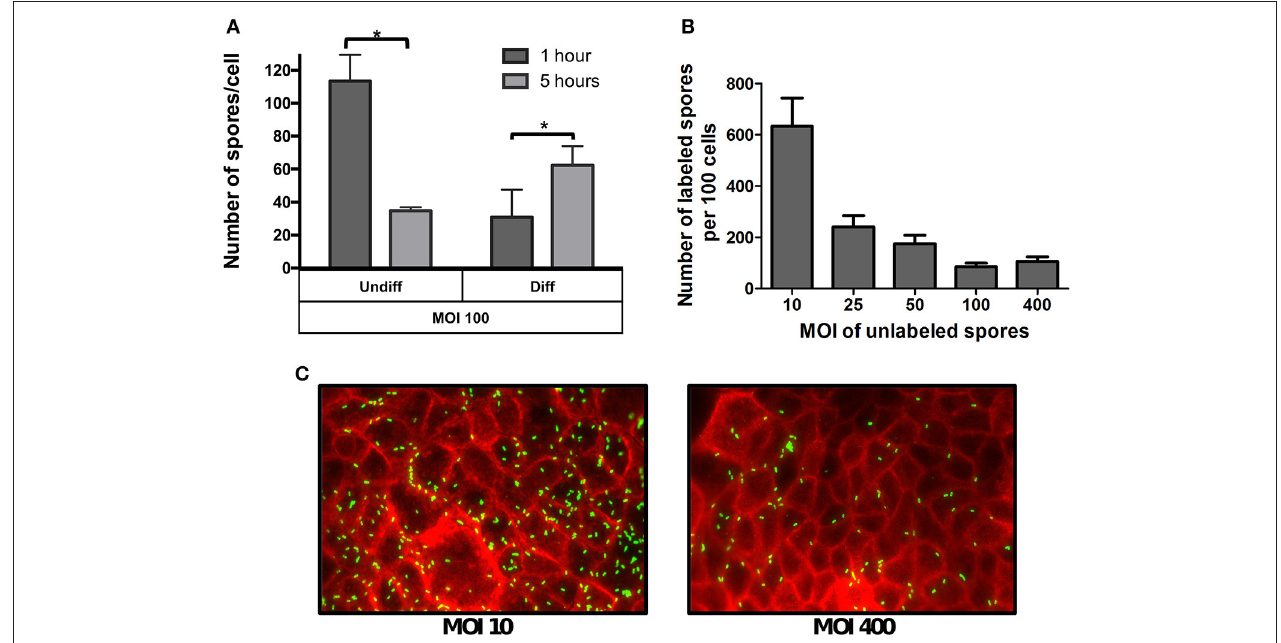
FIGURE 2 | Effect of the multiplicity of infection on spore adherence to intestinal epithelial cells. (A) Monolayers of undifferentiated (Undiff) and differentiated (Diff) Caco-2 cells were infected at multiplicity of infection (MOI) of 100 for 1 (dark gray bars) or 5h (light gray bars), respectively. Unbound spores were rinsed off and, total cells and adhered spores were determined as described in the Method section. (B) Competitive binding of unlabeled and fluorescently labeled C. difficile spores. Monolayers of differentiated Caco-2 cells were infected with different MOIs of unlabeled C. difficile 630 spores for 3h. Then unbound spores were rinsed off, and subsequently infected for 3h at an MOI of 10 with fluorescently labeled C. difficile spores. Unbound fluorescently labeled spores were rinsed off and subsequently processed and the number of fluorescently labeled analyzed by fluorescent microscopy. (C) Representative fluorescence micrographs of adhered fluorescently-labeled C. difficile spores (green) to monolayers pre-infected at an MOI of 10 and 400 with unlabeled spores. F-actin was stained with phalloidin conjugated with Alexa 568 (red). Data represents the mean of three biological experiments and error bars are standard error of the mean. Asterisks (*) denote statistical differences with a P <